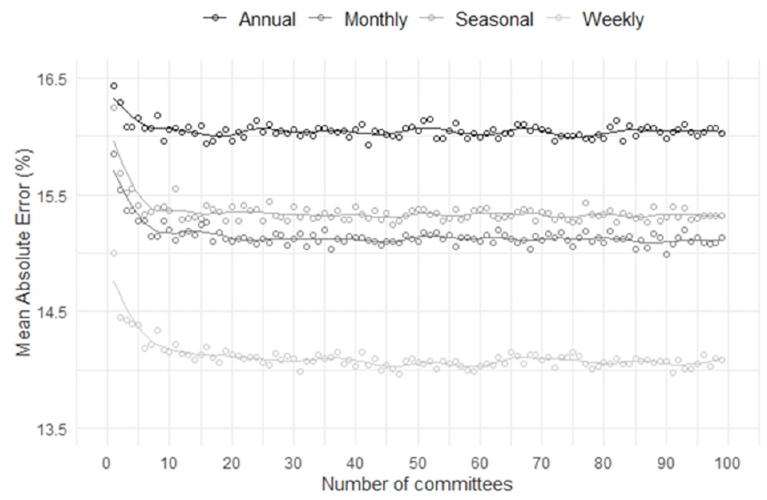
Figure 7. Mean absolute errors (MAEs) calculated from observed and predicted exotic annual grass (%) cover using f -fold cross validation and regression tree models of varying complexity. Models were developed using Normalized Difference Vegetation Index (NDVI) composites and derived phenometrics (for the weekly model only) generated using regression tree models and harmonized Landsat and Sentinel-2 data. Data were fit using a locally weighted scatterplot smoother (LOWESS; span = 0.2) for visualization purposes.